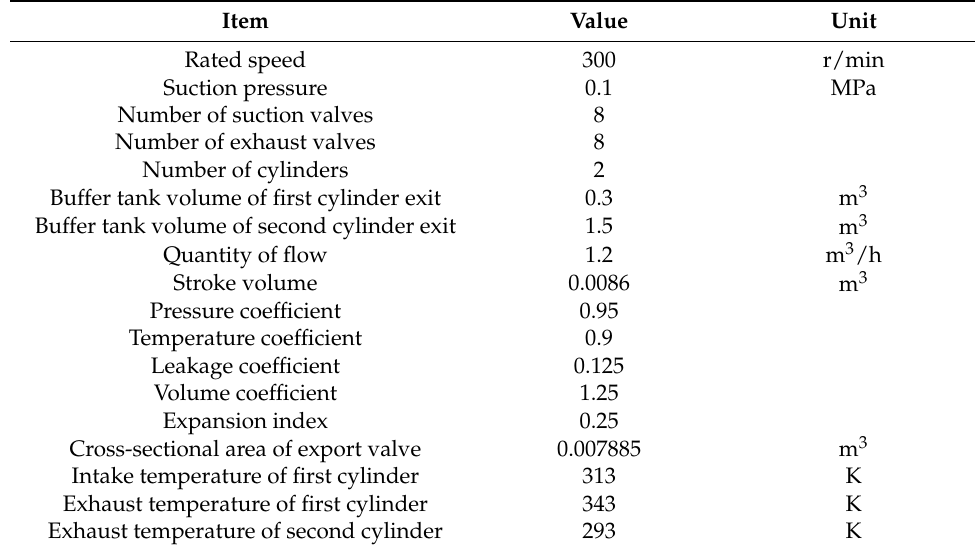
Table 1. Operation parameters of a two-cylinder reciprocating compressor.